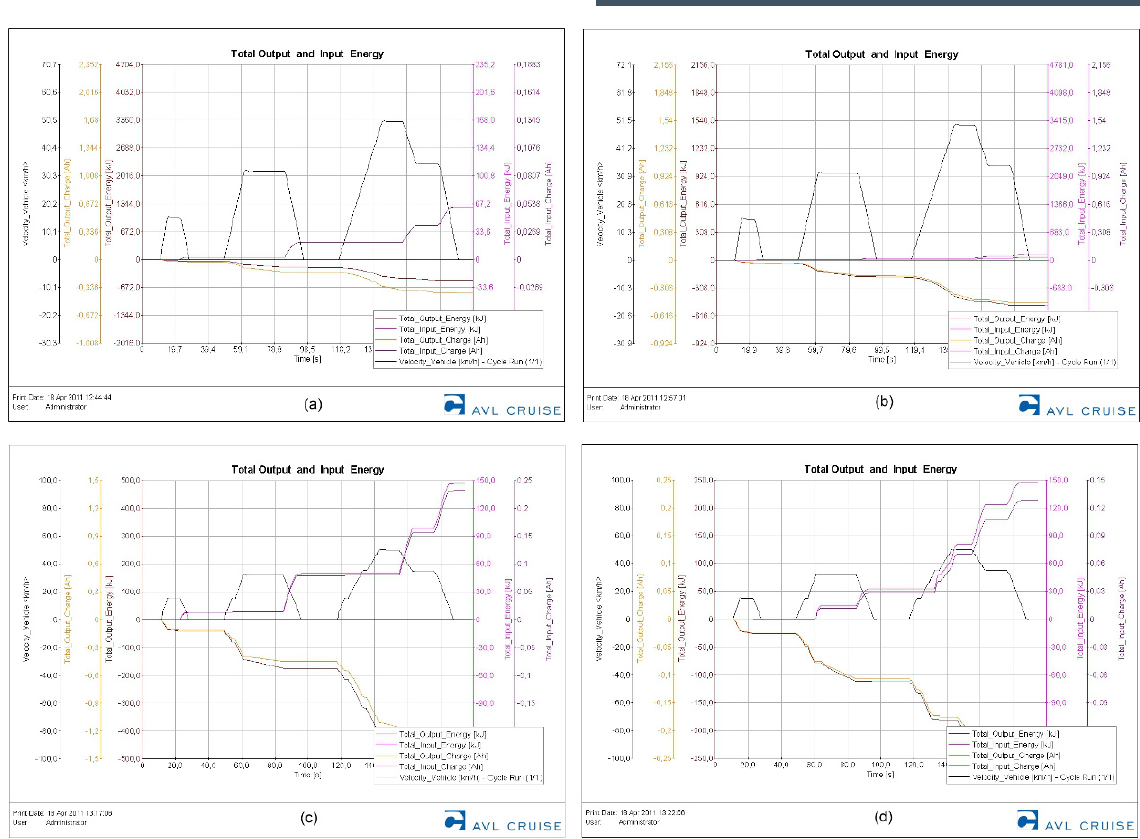
Figure 6. The energy flow in and out from the battery in respect of: Electric vehicle (a), Electric vehicle with range extender (b), Hybrid vehicle with CVT (c), Hybrid vehicle with planetary gearbox (d).